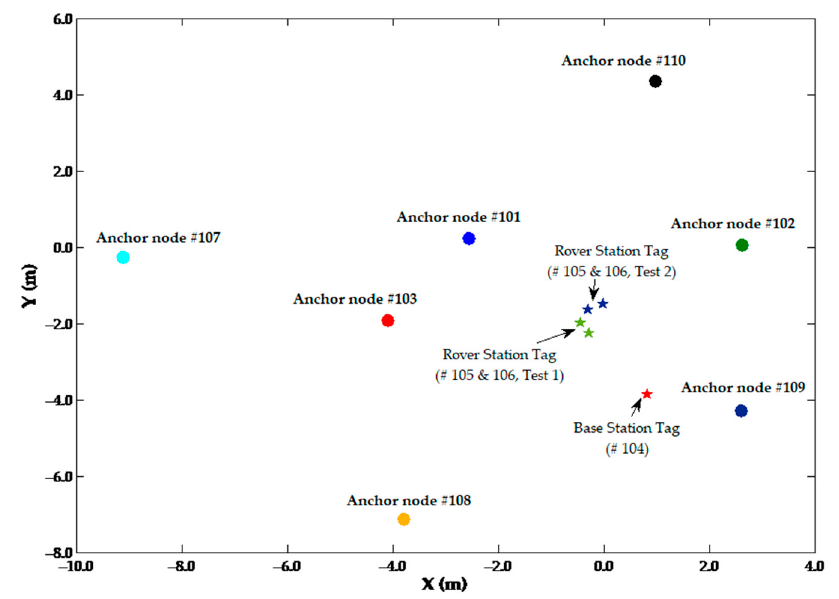
Figure 7. Anchor nodes arrangement in our laboratory.